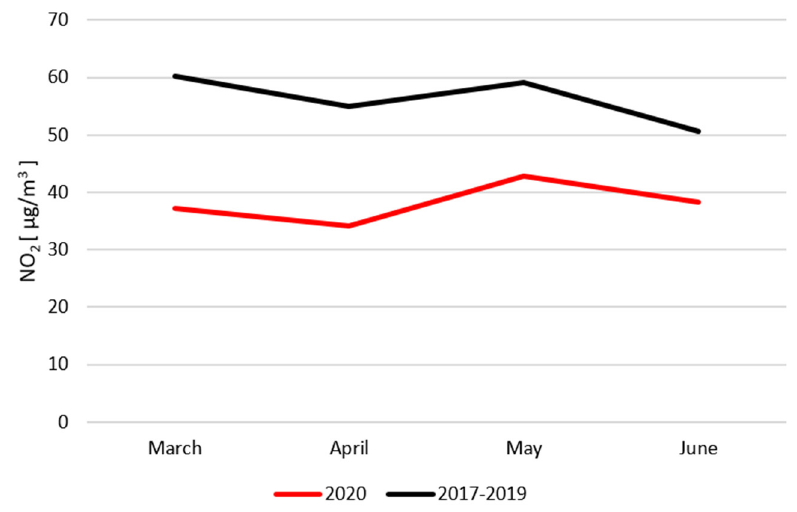
Figure 6. Mean morning peak hour NO 2 concentrations in al. Niepodległo´sci for the period